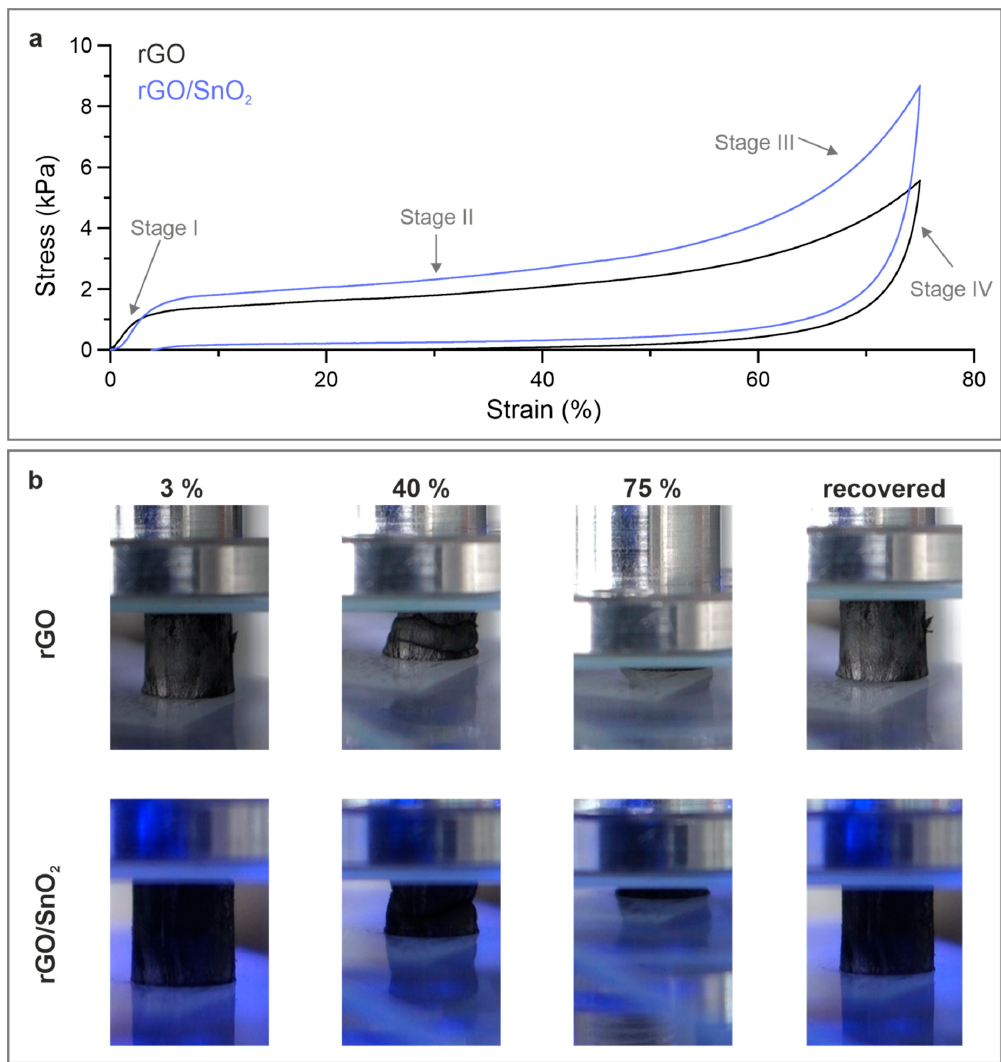
Figure 4. Mechanical performance of the rGO and rGO/SnO 2 aerogels under compression. ( a ) The compressive stress–strain curve with ( b ) the corresponding in situ images of the different compression states.